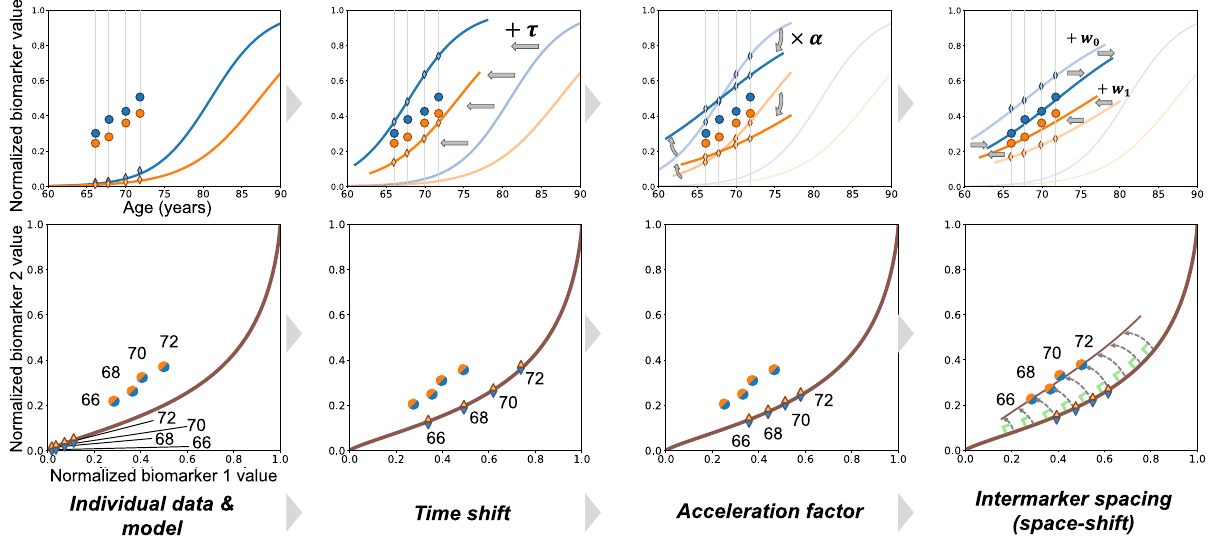
Figure 1. Disease course mapping for two biomarker data. Top left panel: the model as plain curves and repeated data of one subject. x-axis is age in years and y-axis is the normalized values of the biomarkers. Top row, three left panels: the three operations used to mapping the model to the individual data: the time-shift translates the curves, the acceleration factor scales the abscissa, the space-shifts change the time interval between both curves. Bottom row shows another representation of the same data as parametric curves. Panels plot the values of one biomarker versus the other one, time being the parameter. Data fall within a unit square, which is